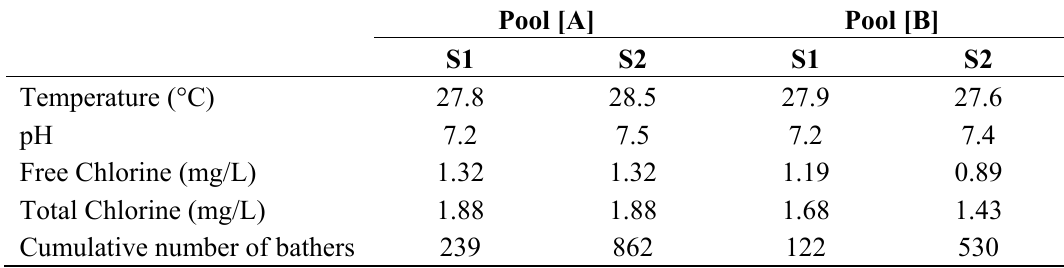
Table 3. Mean physicochemical parameter values and cumulative number of bathers in [A] and [B] during S1 and